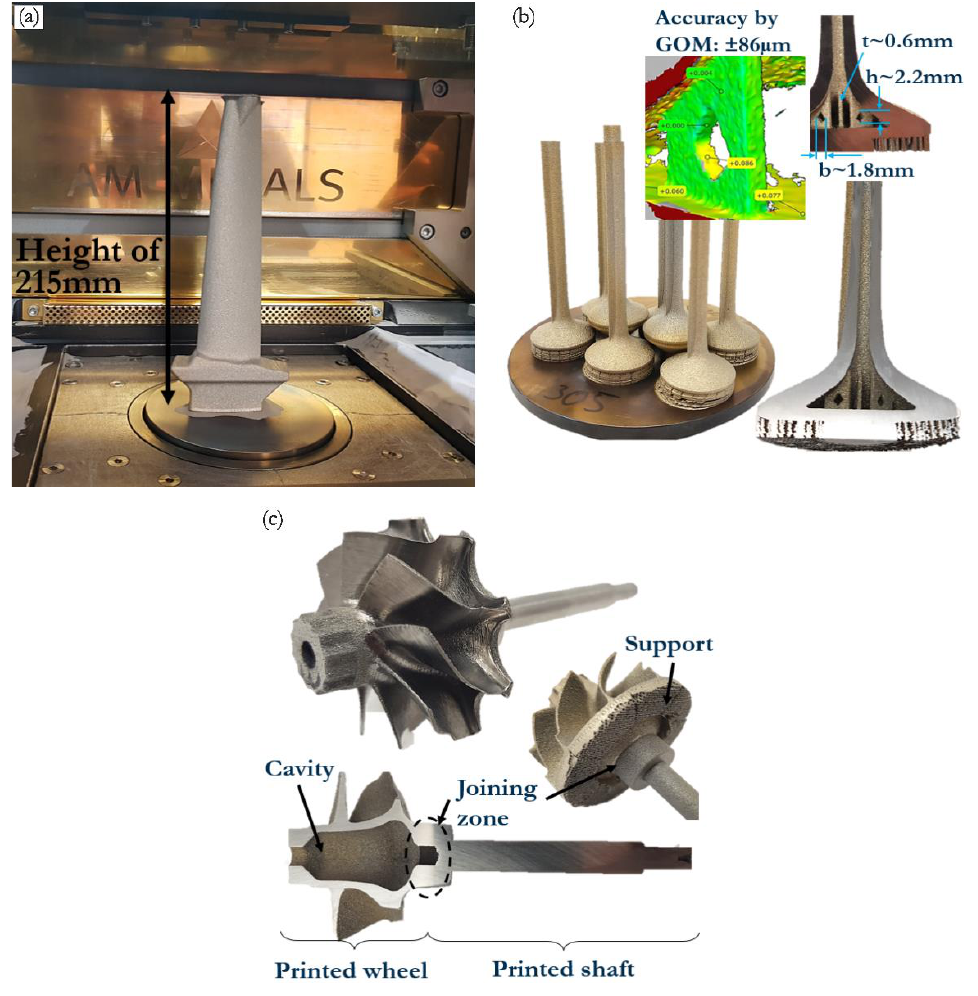
Figure 9. ( a ) Demonstrator aero engine LPT blade made from TNM alloy powder in the process chamber of an EOS-M290-HT LPBF machine; ( b ) base plate with eight fabricated TNM outlet valves in a solid or hollow version along with descriptions of geometrical features. The head of the valve has a diameter of ~30 mm and the stem exhibits an outer diameter of 5.5 mm and a length of 90 mm; ( c ) exemplary turbocharger turbine wheel, which was directly printed on the shaft using hybrid manufacturing technology with a cavity in the wheel as can be seen in the cross-sectional cut. The diameter of the wheel is ~40 mm and the shaft length is ~80 mm.